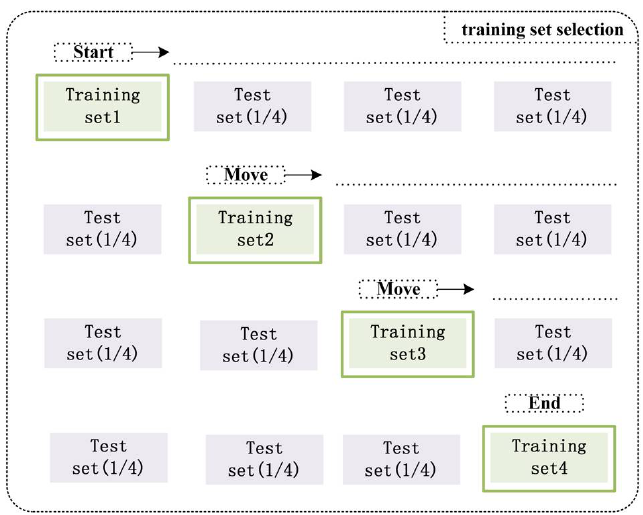
Figure 6. Diagram of training set selected.